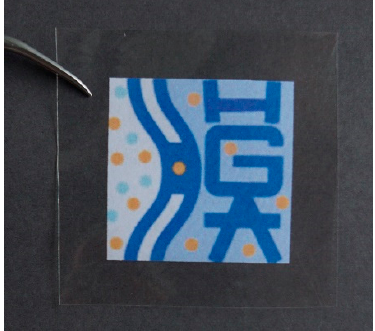
Figure 4. Photograph of one of the prepared B-CEMs.